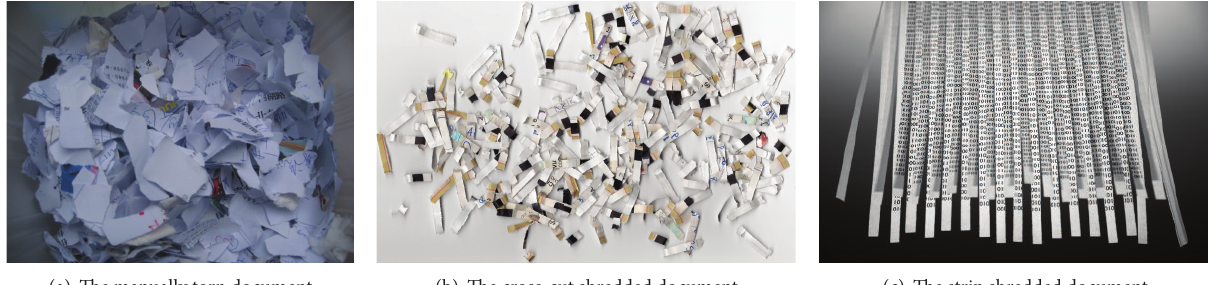
Figure 1: The document shredded by hand (a) and by paper shredder ((b), (c)).